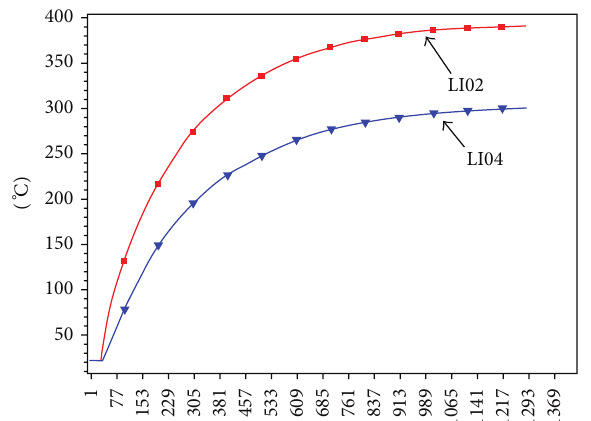
Figure 5: Resistor temperature profile from different aspects.